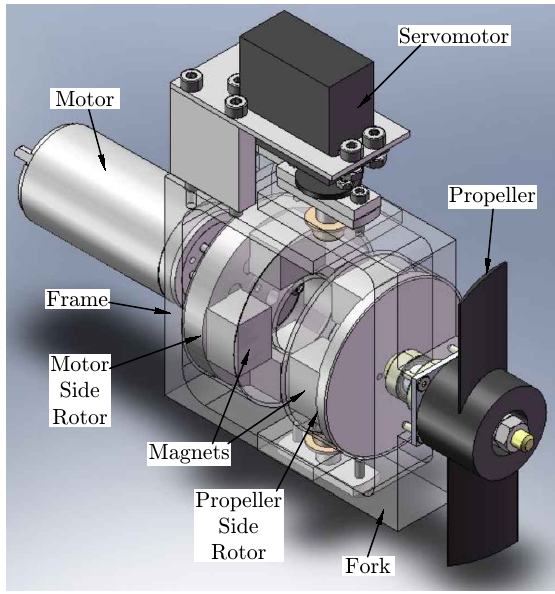
Figure 15. Flat-RMCT CAD assembly